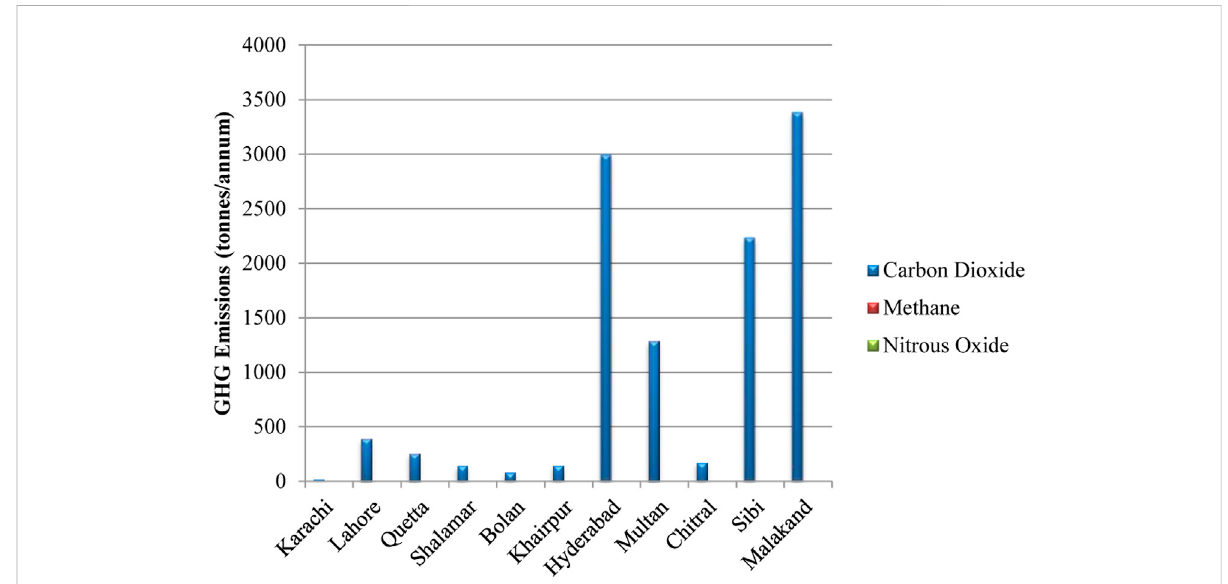
FIGURE 4 Breakdown of annual GHG emissions load from all vessels of PNSC based on fuel consumption (MGO).